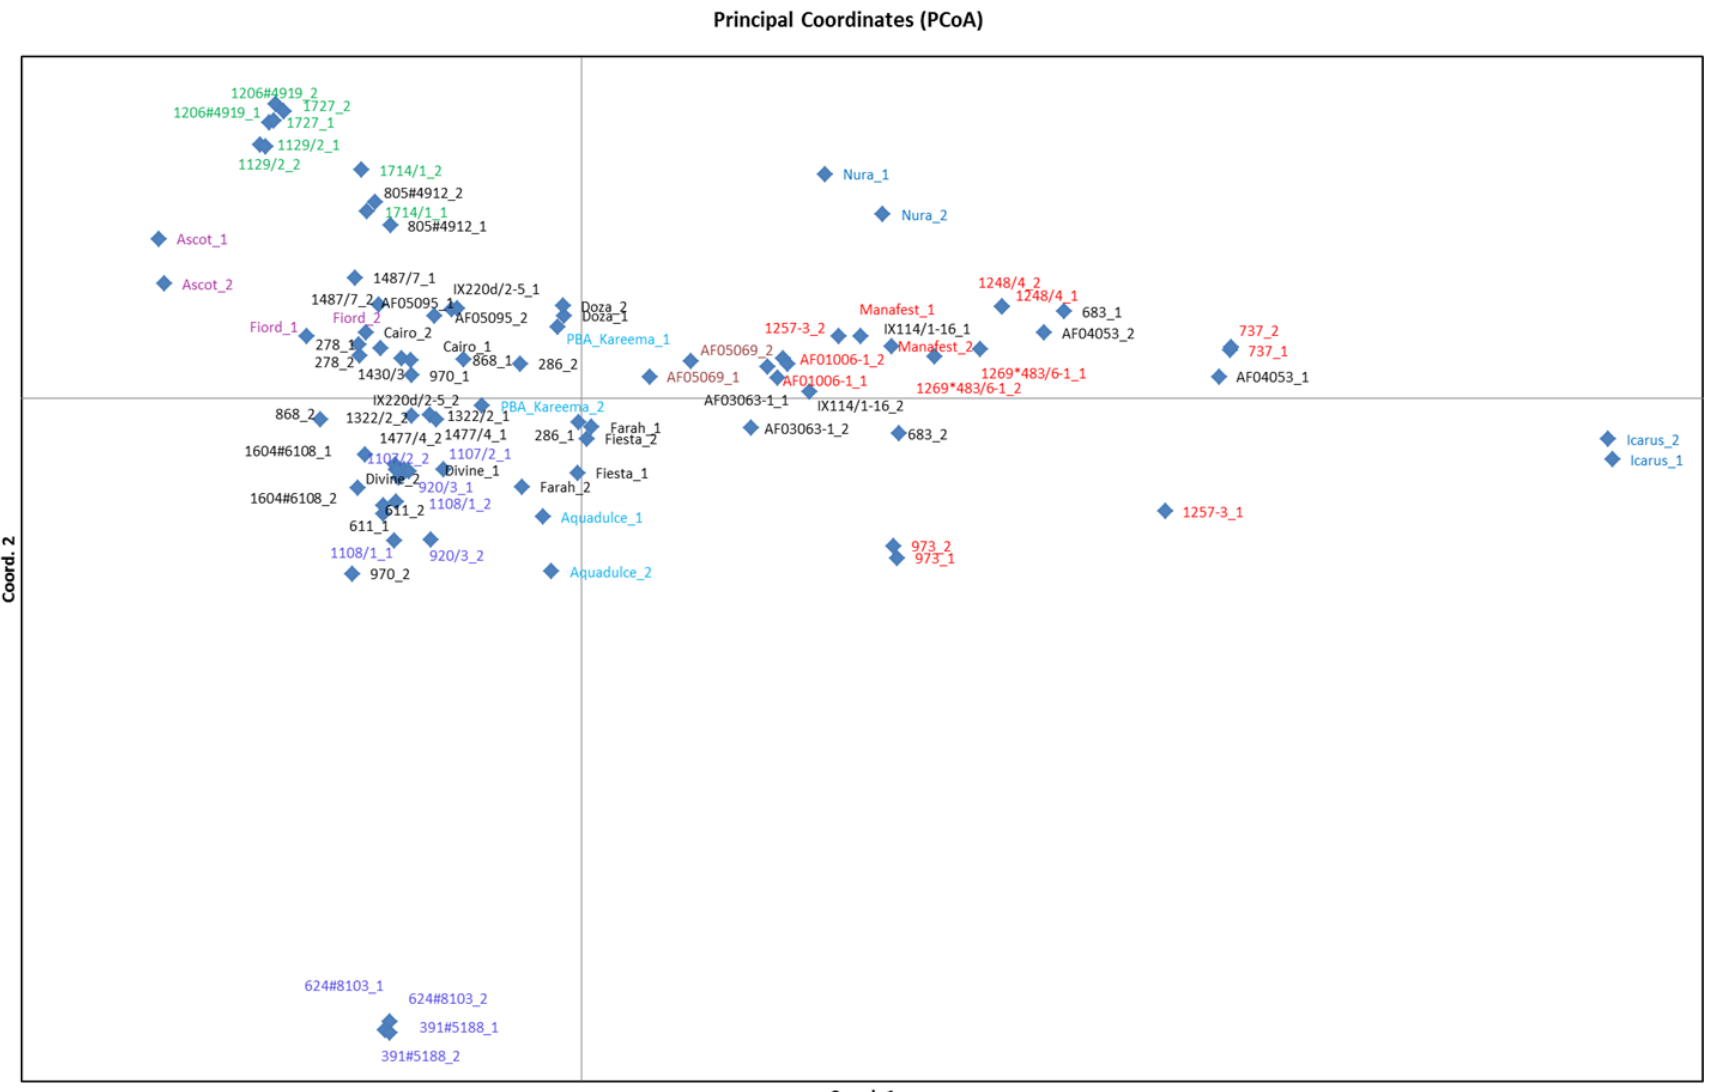
Figure 2. Principal component analysis (PCoA) bi-plot generated from genetic distance calculations obtained using the GENALEX